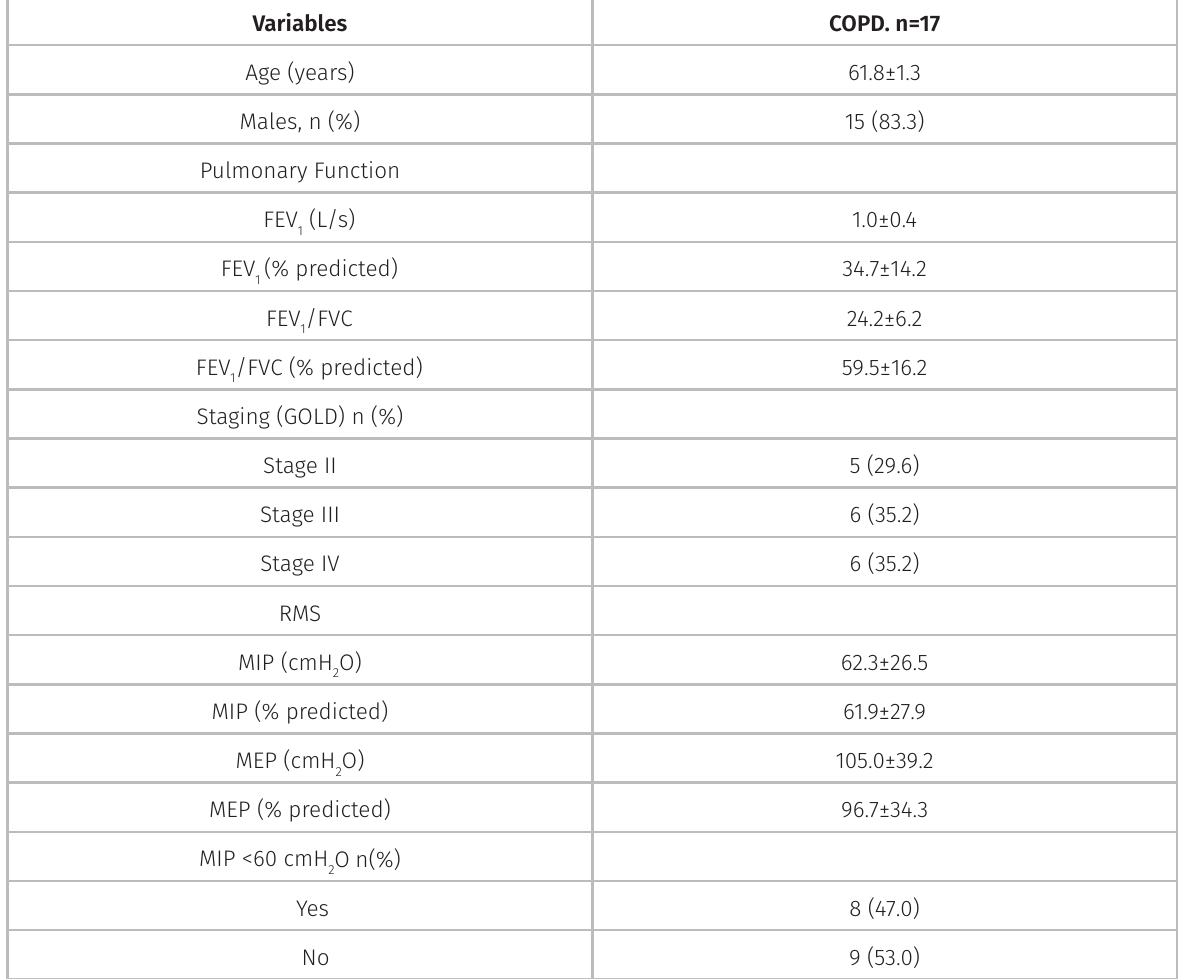
Table I. COPD patients’ clinical